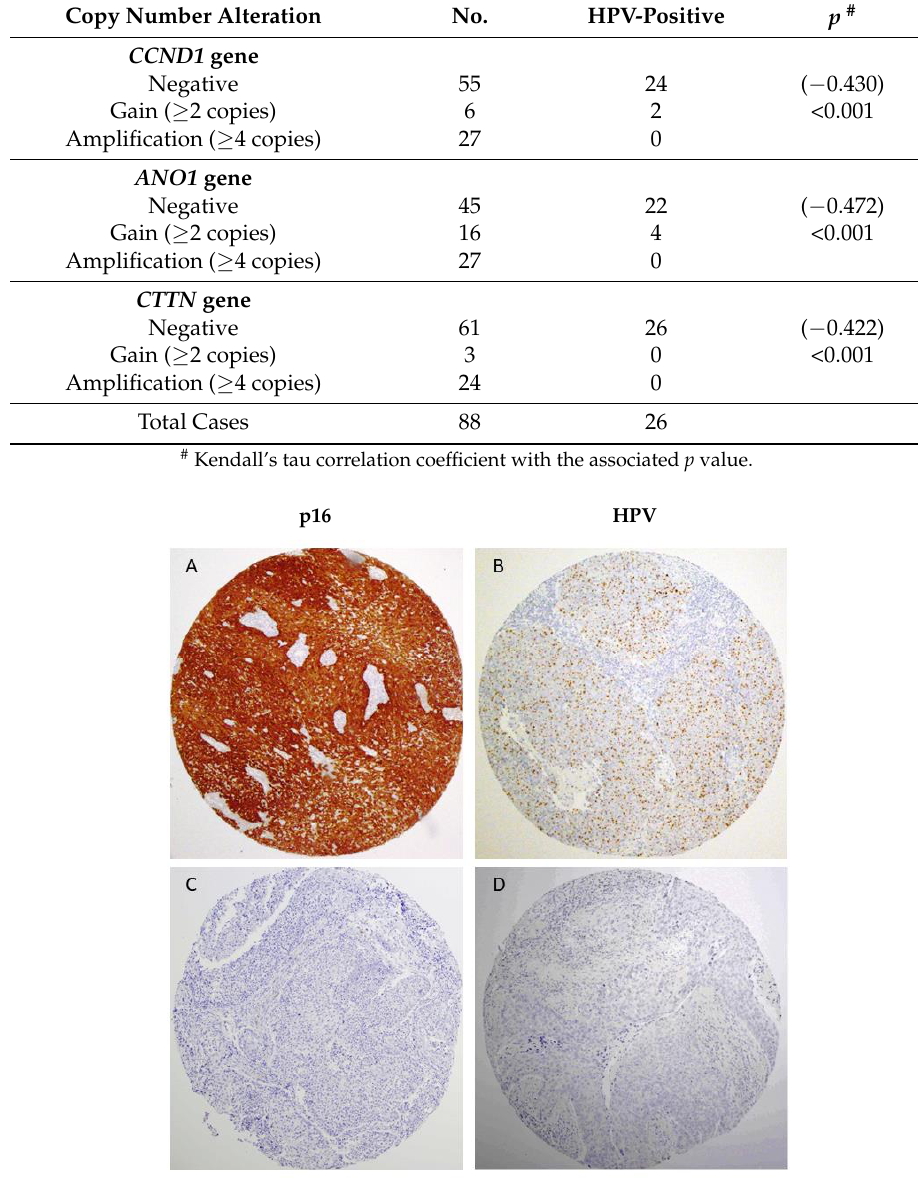
Figure 1. Representative images of p16-positive ( A ) and negative ( C ) immunostaining in the HNSCC tissue microarrays (TMAs) and HPV-positive ( B ) and HPV-negative ( D ) cases detected by in situ hybridization. Original magnification ×10.